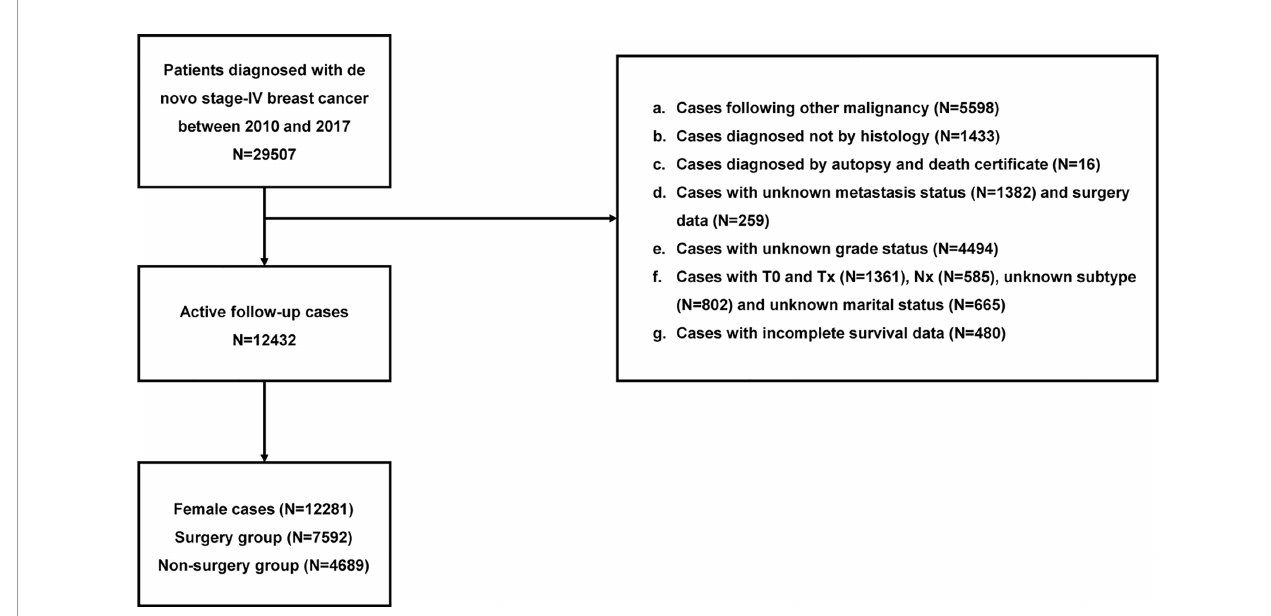
FIGURE 1 | Flow chart of patient